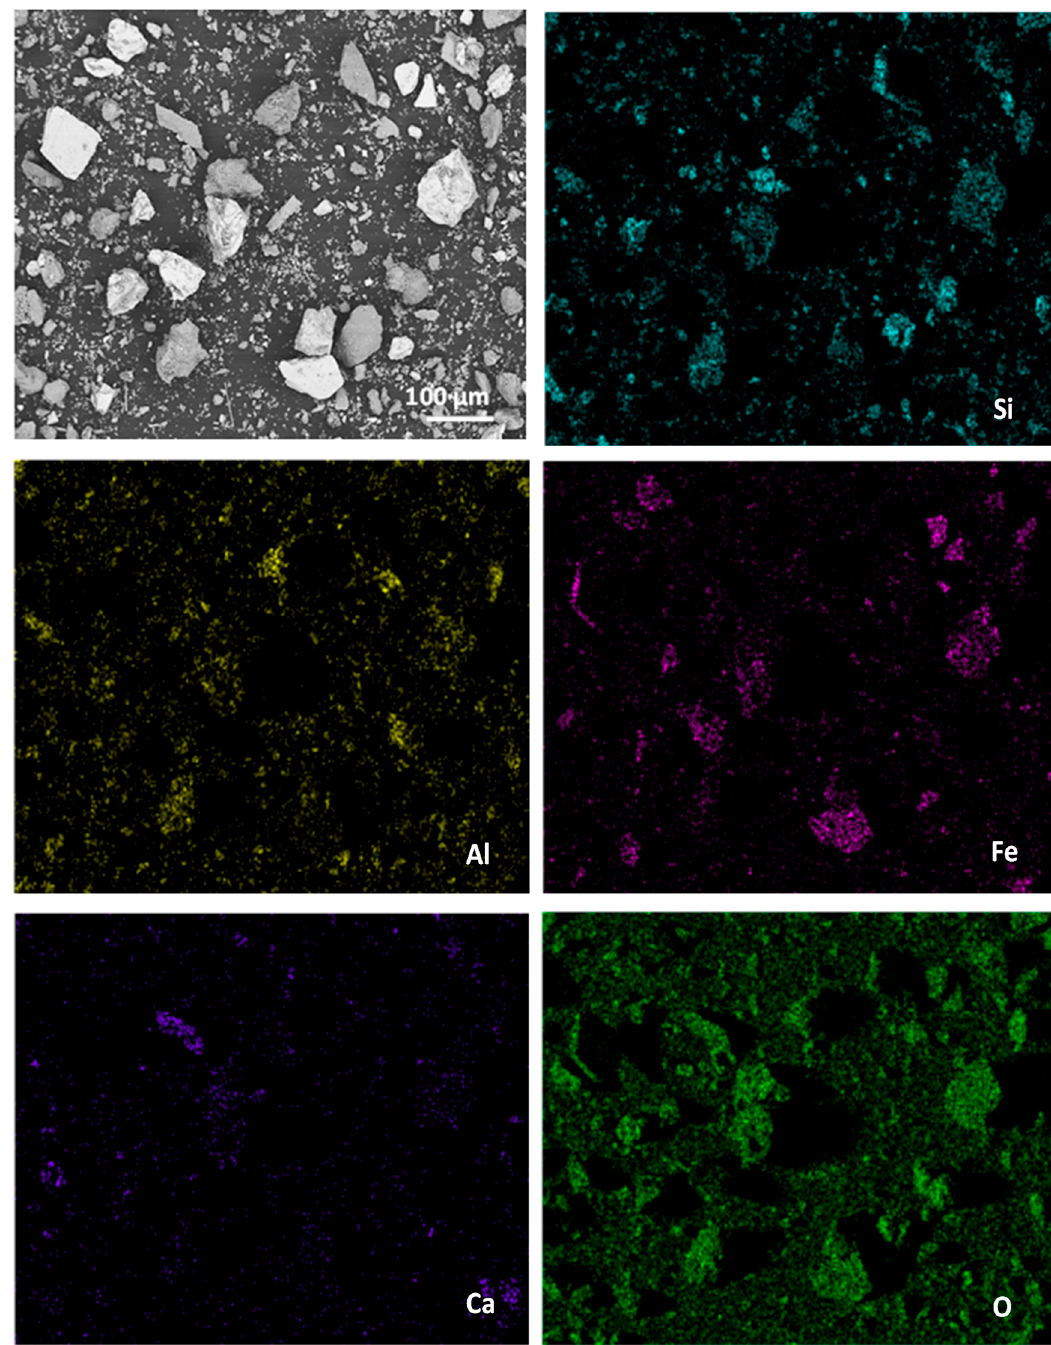
Figure 3. SEM images and EDX analysis of the industrial copper tailings particles.